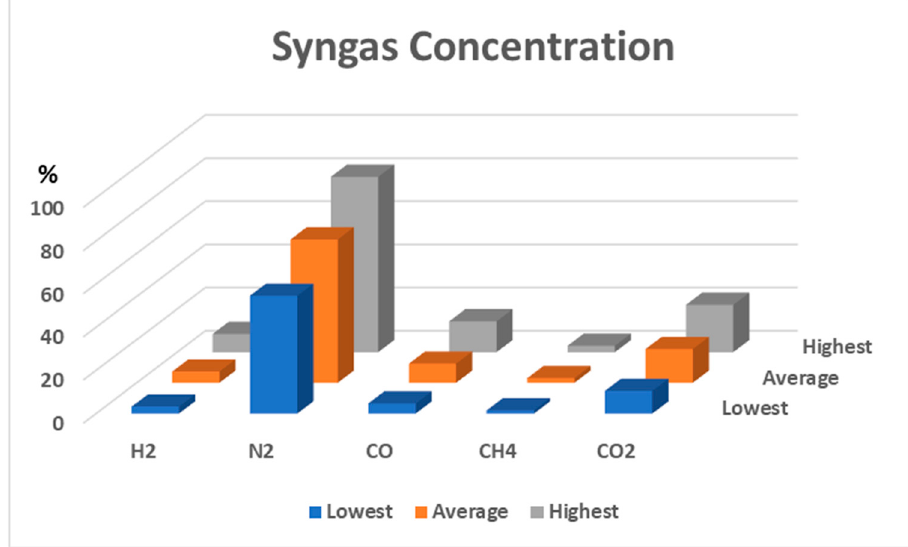
Figure 6. Syngas compositions during air and steam-air gasification with 0 kg/h of steam.